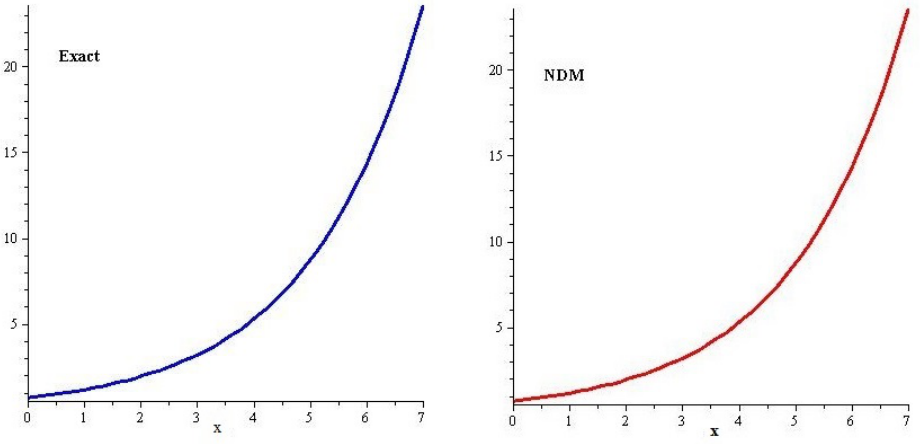
Figure 2. Exact and NDM solutions at γ = 1 of Example 1.